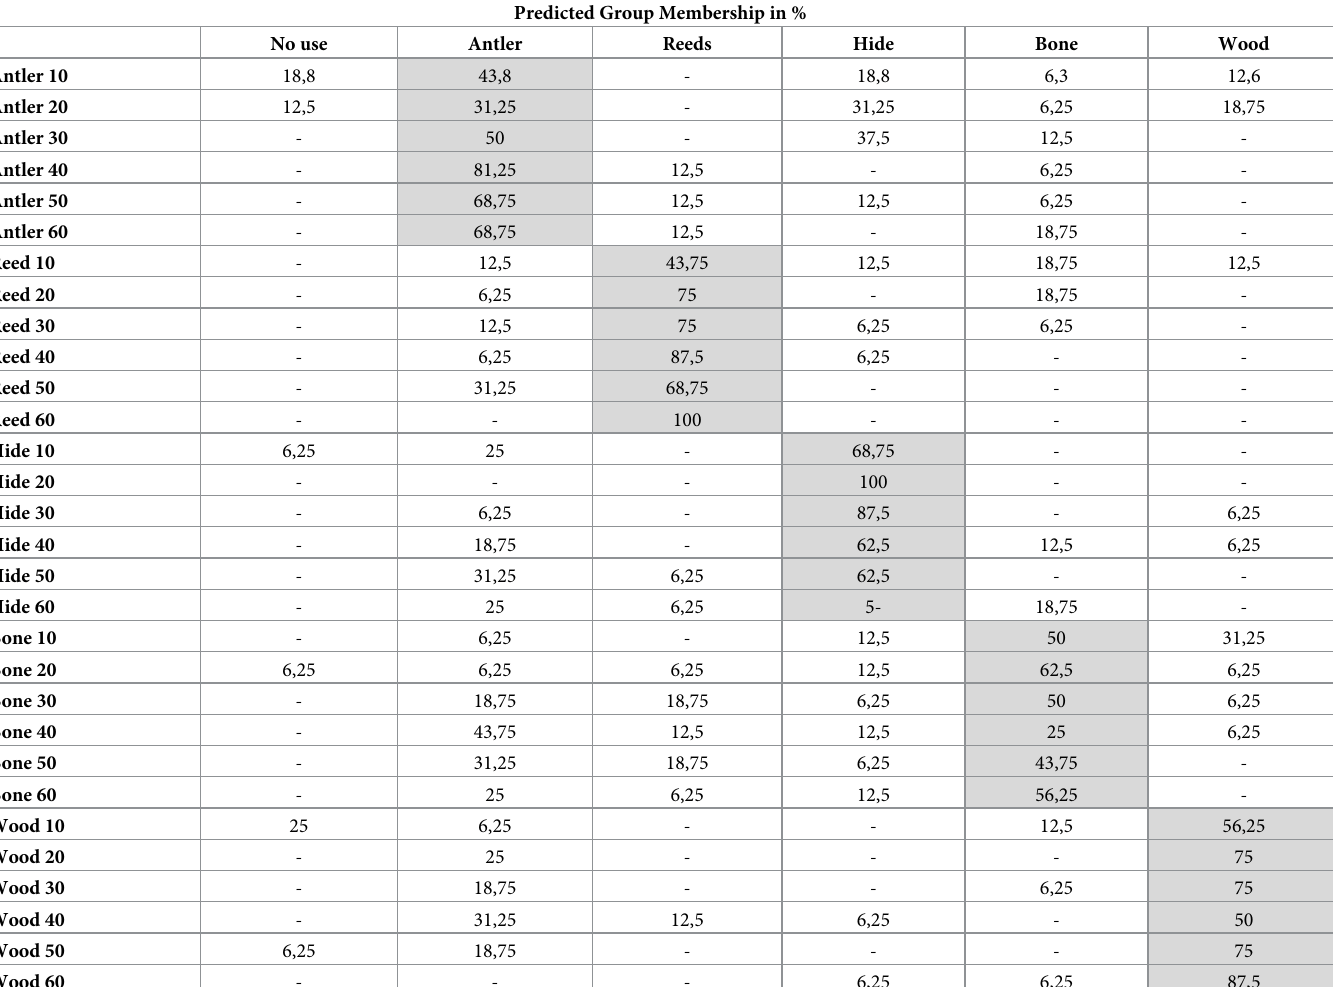
Table 7. Summary by worked material of the results of classification of the five worked materials (antler, reed, hide, bone and wood) every 10 minutes of use by qua- dratic discriminant analysis. Half of the surface samples (n = 16) of each group of worked material/time of use (i.e. bone 10 minutes, hide 20 minutes ... ) were blindly classified in 16 groups of worked materials and four intervals of time of use (0, 10–20, 30–40, 50–60 minutes). Shaded cells indicate the correct classification.